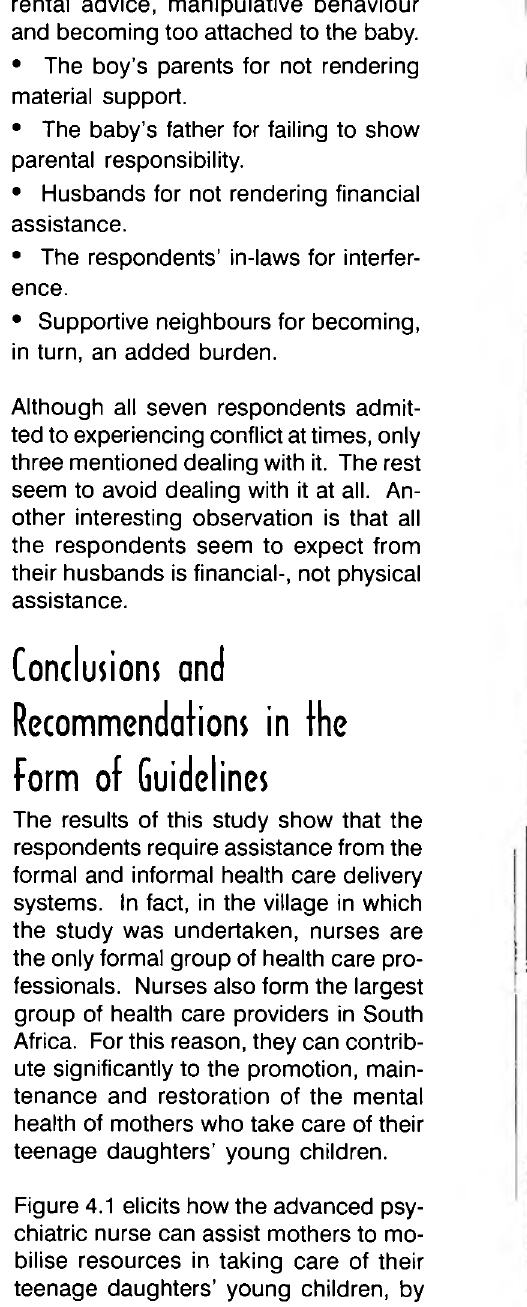
Figure 4.1 elicits how the advanced